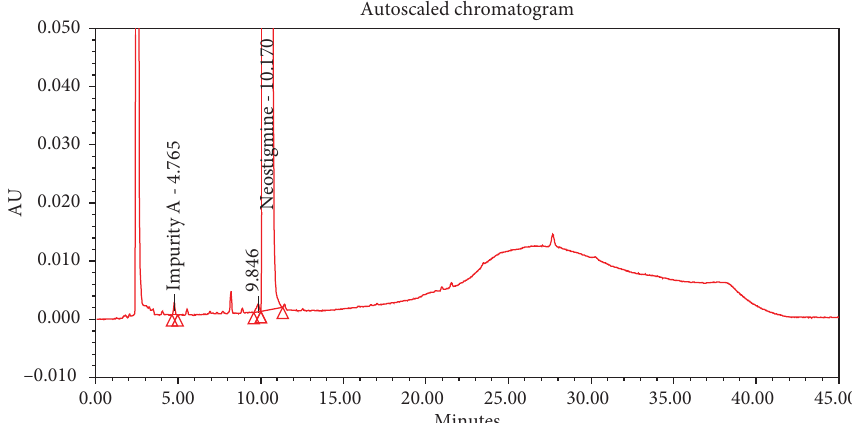
Figure 9: Chromatogram of oxidative hydrolysis of neostigmine methylsulfate API (2mL of 30% H